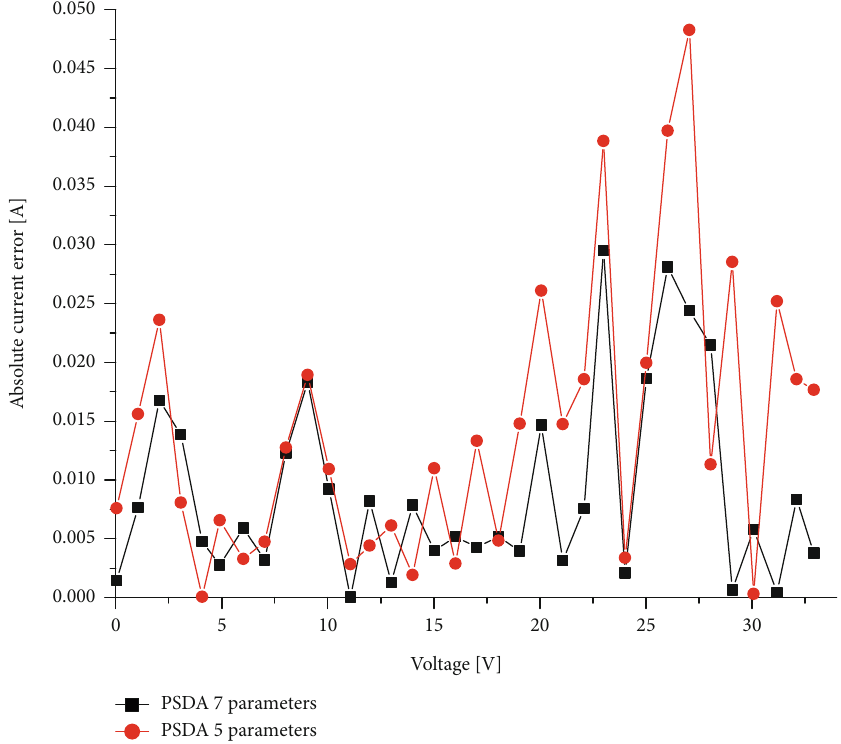
Figure 10: Comparison between the two-diodes and one-diode model for the Kyocera KC200GT